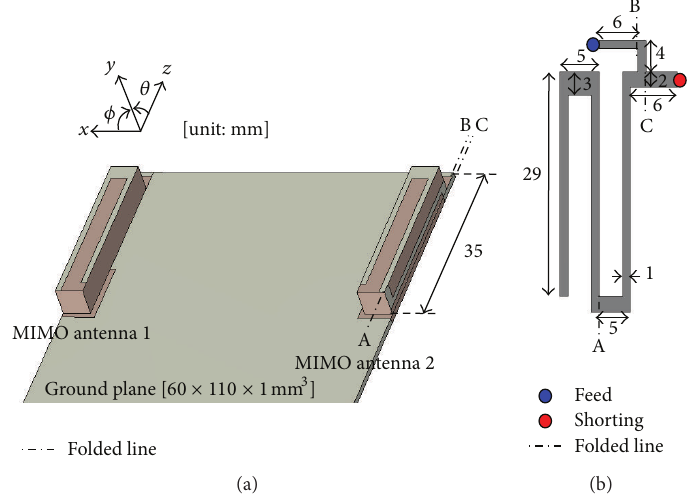
Figure 1: Geometry of the proposed LTE MIMO antenna; (a) overall view and (b) detailed view of antenna element.